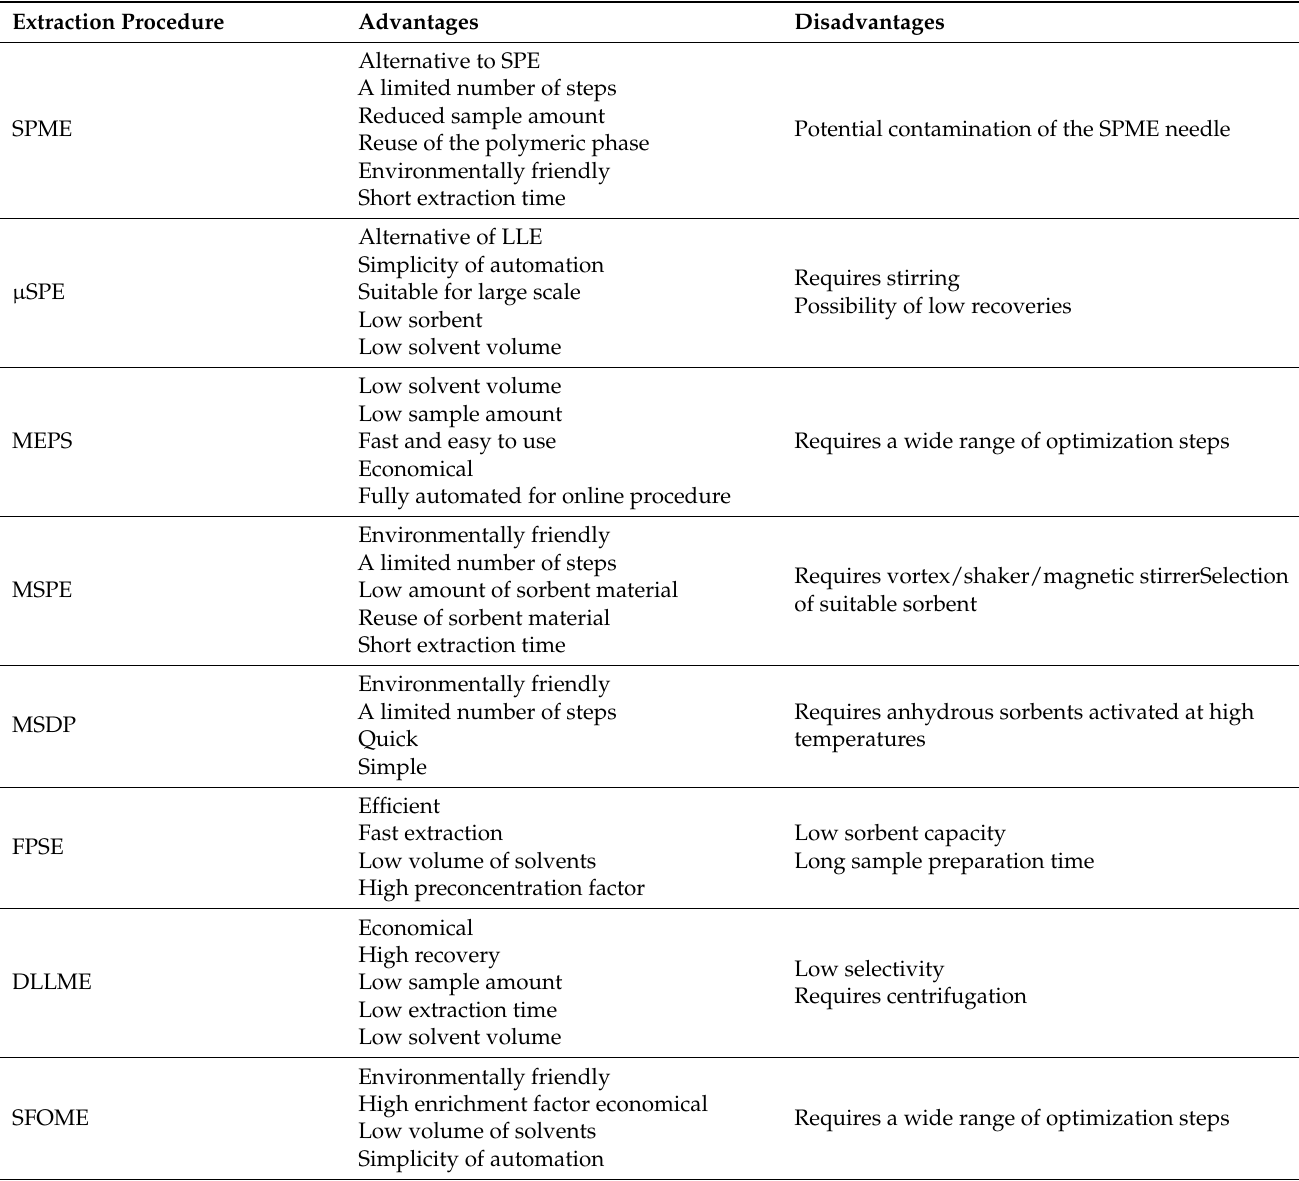
Table 1. Advantages and disadvantages of some GreETs commonly used in the analysis of biological, food, and environmental